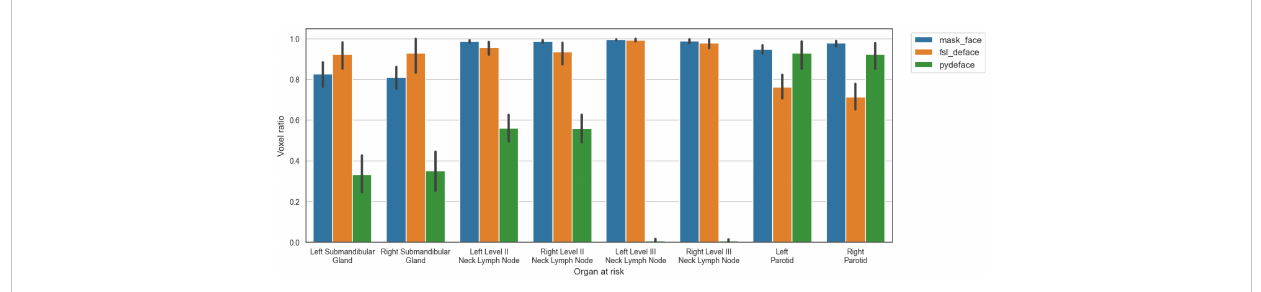
FIGURE 2 Ratio of preserved voxels in comparison to the original segmentation mask after defacing (mask_face, fsl_deface, and pydeface) for each of the organs at risk, where defacing was successful for N=39, N=42, and N=45, respectively. The mean and standard deviation are represented as the center and extremes of the error bars, respectively.